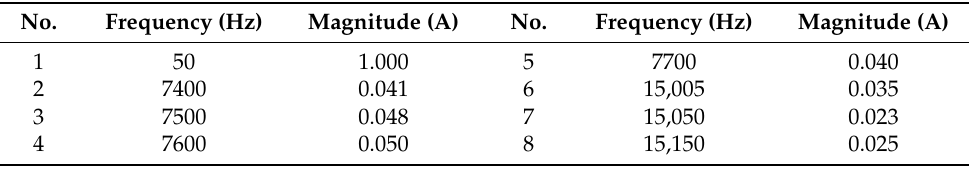
Table 1. Frequency and magnitude of the synthetic signal.